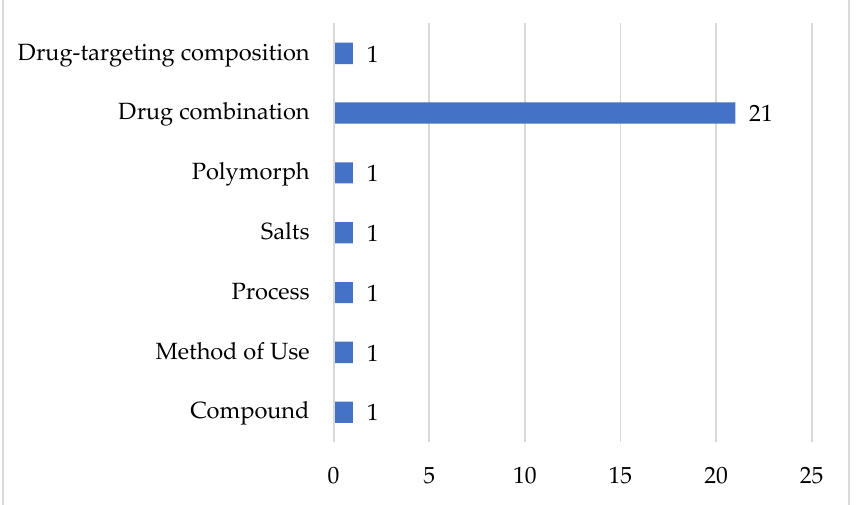
Figure 7. The types of patents filed for mobocertinib.